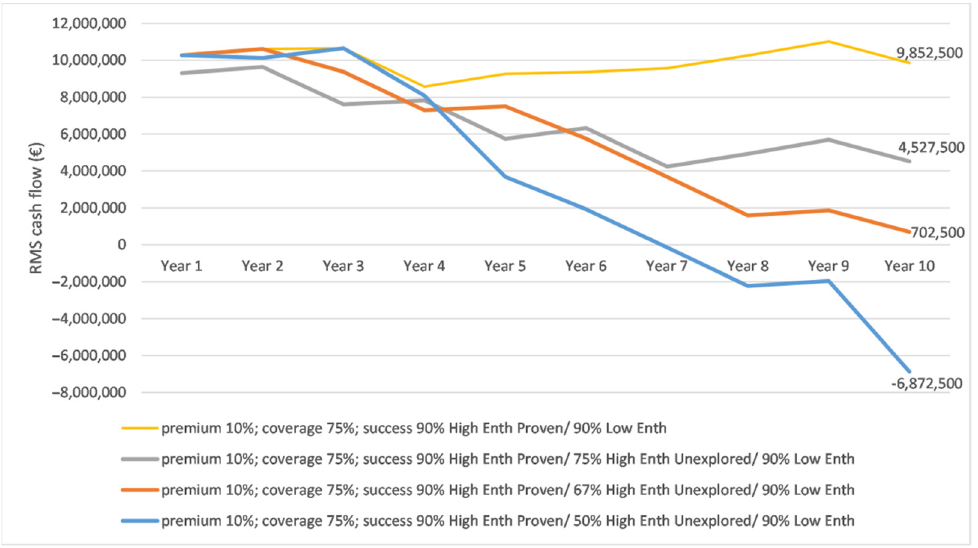
Figure 7. Success rates’ impact on the 10-year cash flow.